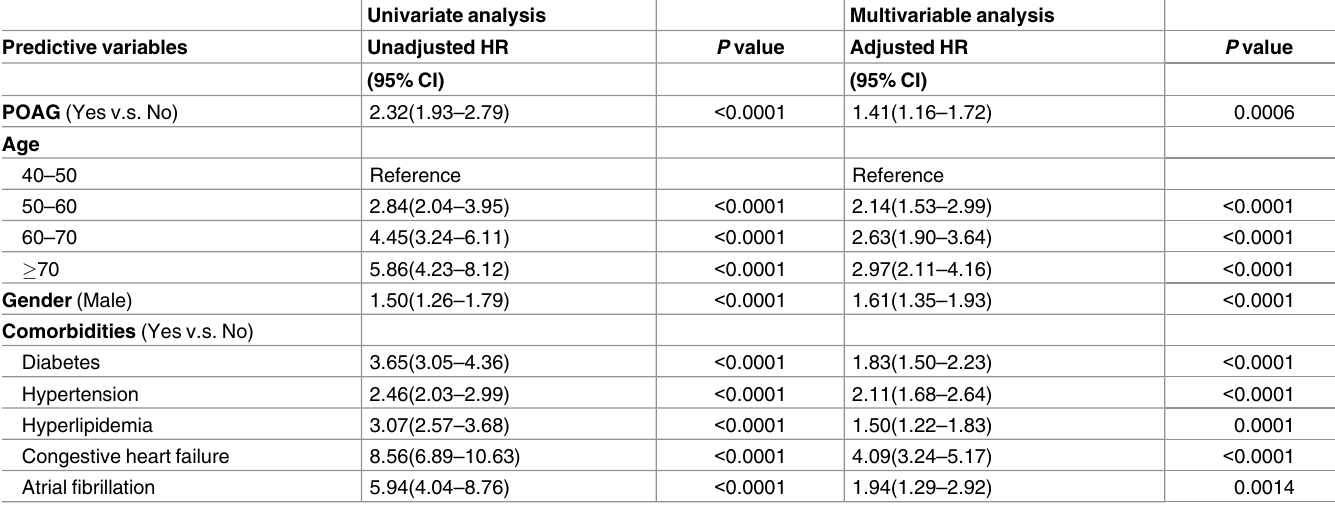
Table 2. Analyses of Risk Factors for IHD in Patients with and without